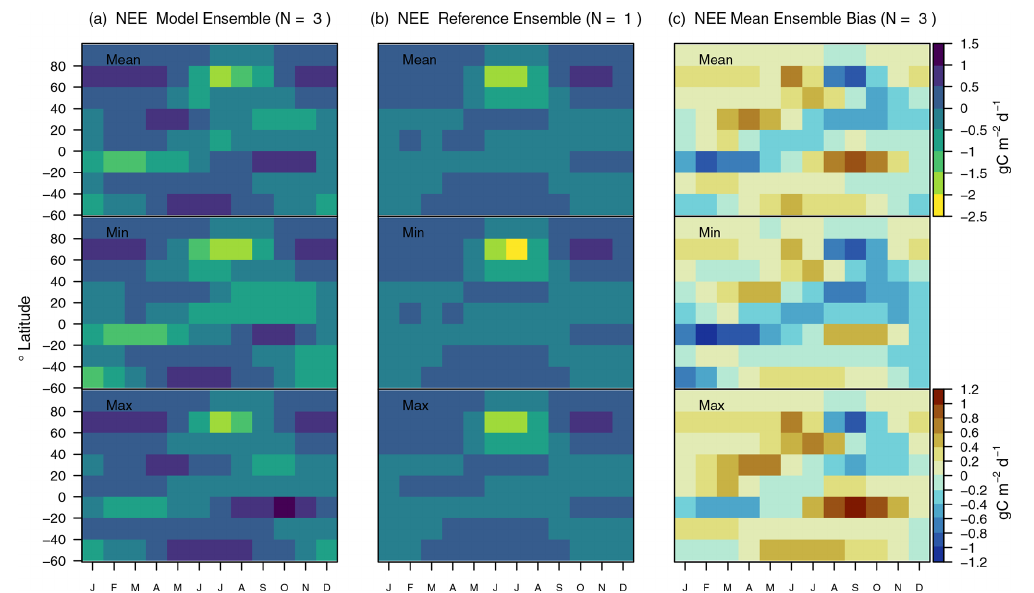
Figure A18. Same as in Fig. 8 but for net ecosystem exchange.